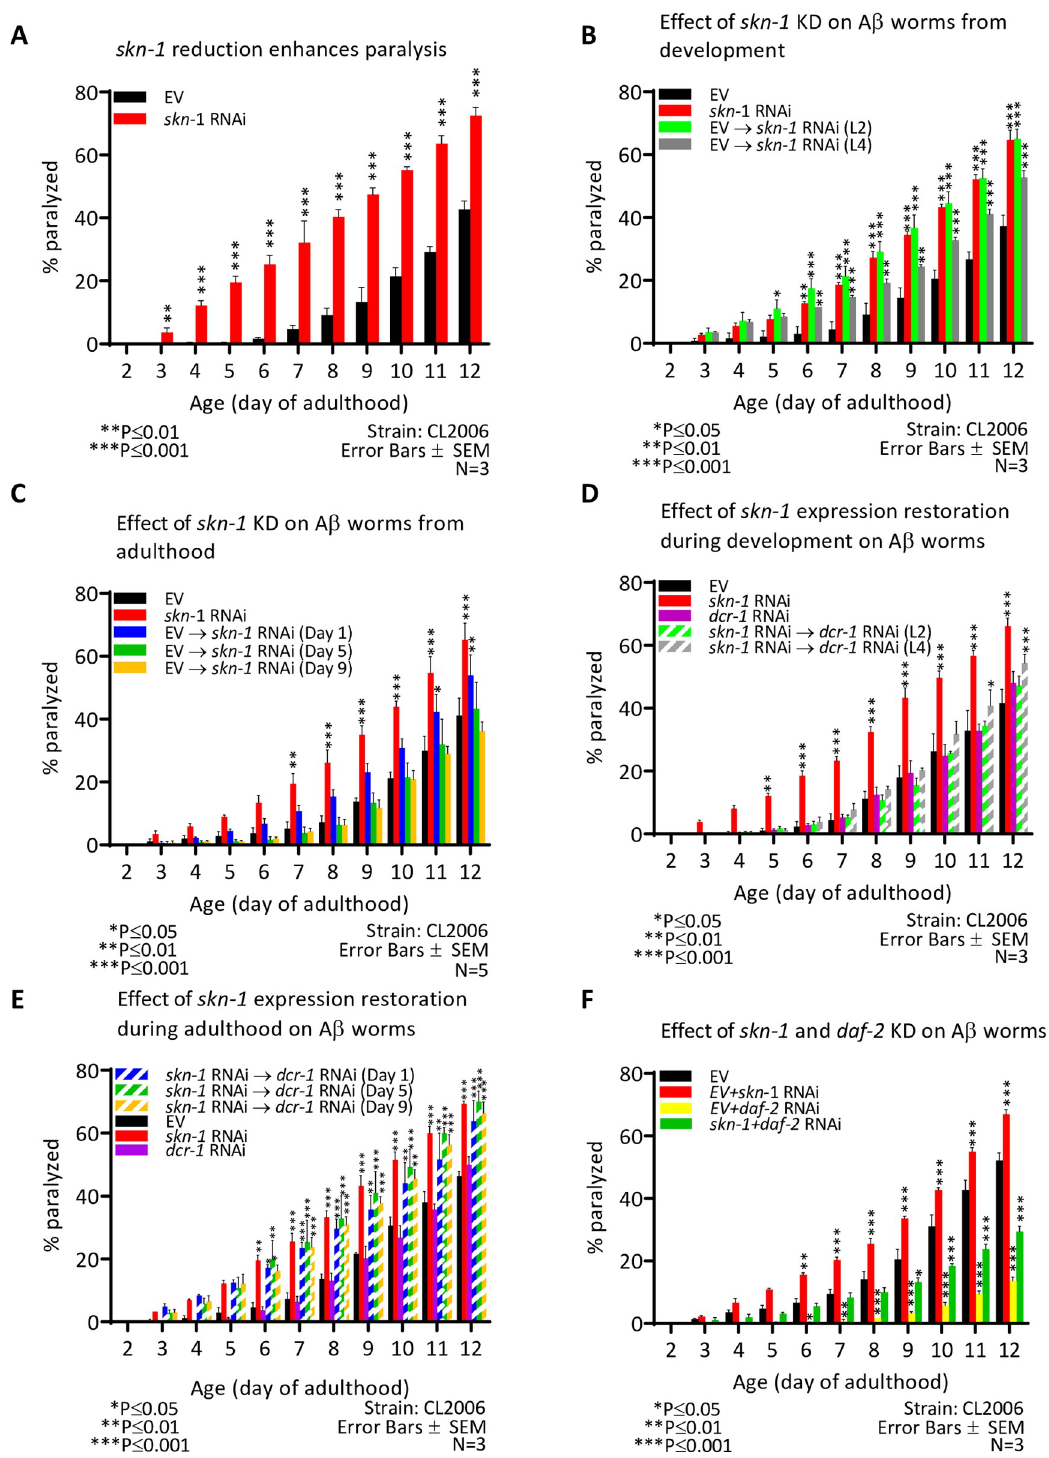
Fig 2. skn-1 is foremost important from late stages of larval development through day 1 of adulthood to protect against A β - induced proteotoxicity. ( A ) The knockdown of skn-1 significantly enhances the rate of paralysis of A β worms as observed in three independent repeats (p < 0.001 see also S2C Fig). EV: n = 282, 78 censored; skn-1 RNAi: n = 352, 8 censored. ( B ) Treating A β worms with skn-1 RNAi from the L2 larval stage enhances the rate of paralysis as efficiently as lifelong treatment with skn-1 RNAi. In contrast, knocking down skn-1 RNAi from the L4 larval stage less pronouncedly, but significantly enhances the rate of paralysis.